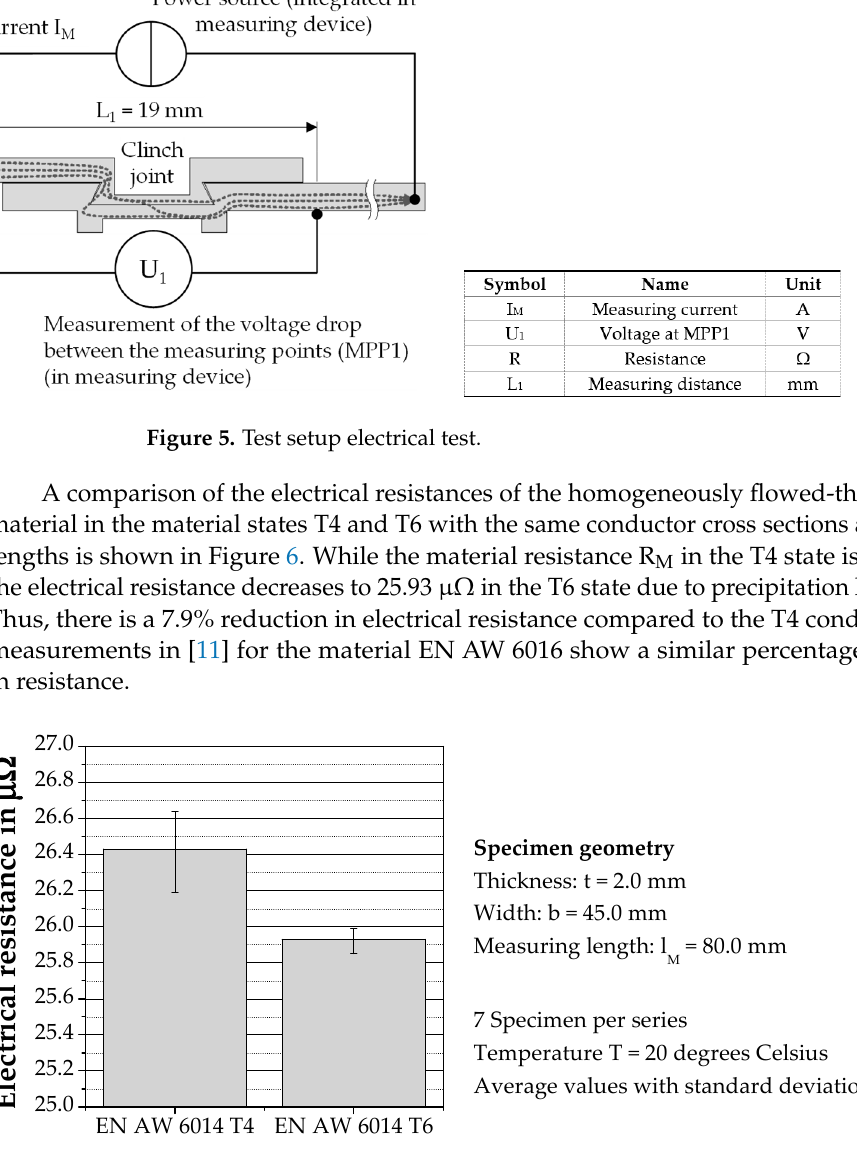
Figure 6. Material resistance of the test material before and after precipitation hardening .